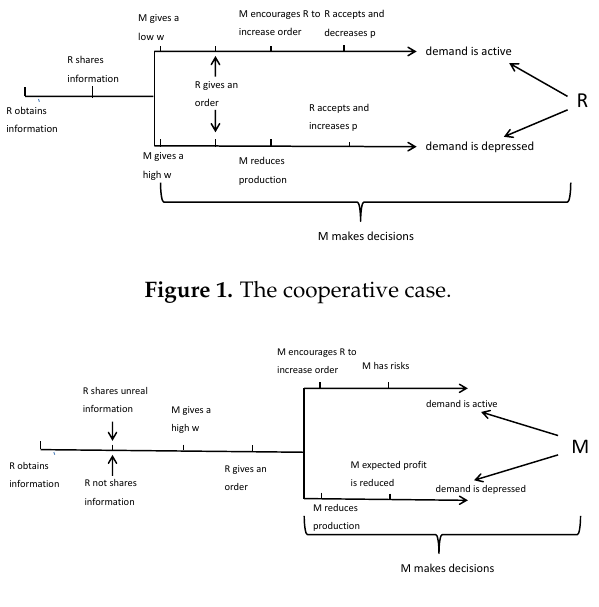
Figure 2. The non-cooperative